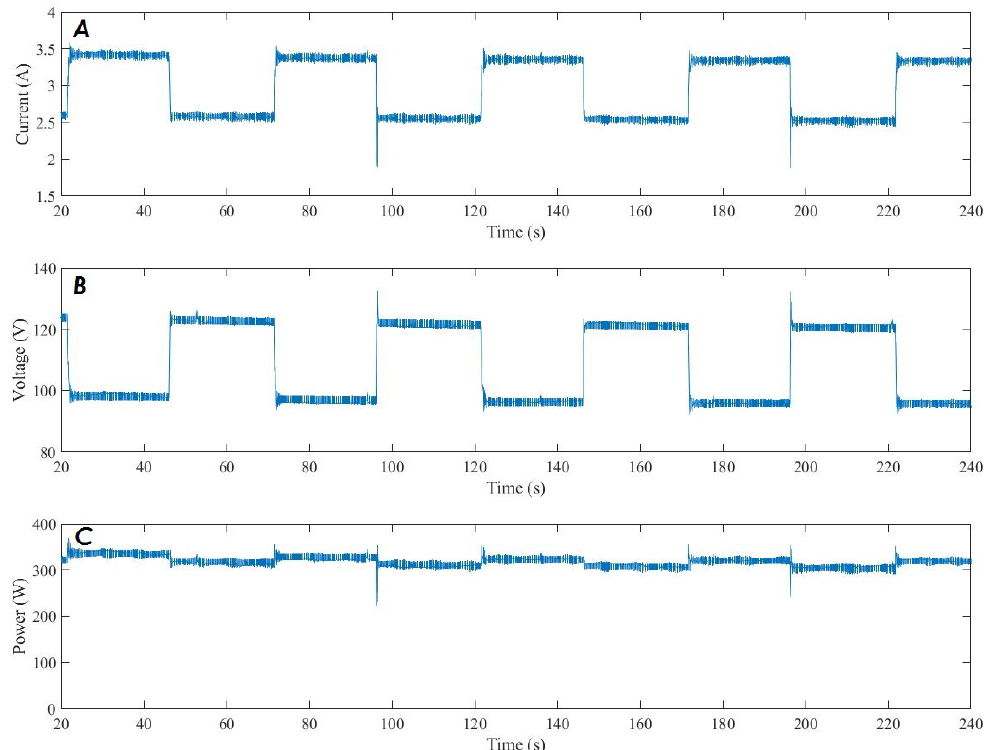
Figure 17. Control results: ( A ) the converter output current; ( B ) the converter output voltage; ( C ) the converter output